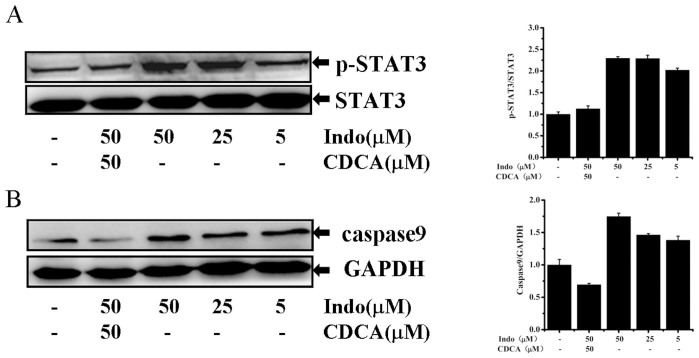
Indomethacin induce liver injury related biochemical events in HepG2 cell.(A) Indomethacin induces STAT3 phosphorylation in a dose-dependent manner. The HepG2 cells were grown to about 70% to 80% confluence in complete medium and then cultured in low serum medium in the presence of CDCA or indomethacin at the concentration indicated. The phosphorylated STAT3 was determined by western blot analysis. (B) CDCA could suppress indomethacin-induced caspase9 activation. HepG2 cells were treated with indomethacin or CDCA for indicated concentrations and the protein level of caspase9 and GAPDH were detected by western blot.